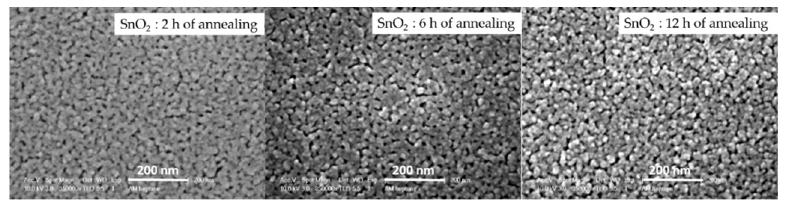
Figure 5 . SEM images of the deposited samples at different annealing times.